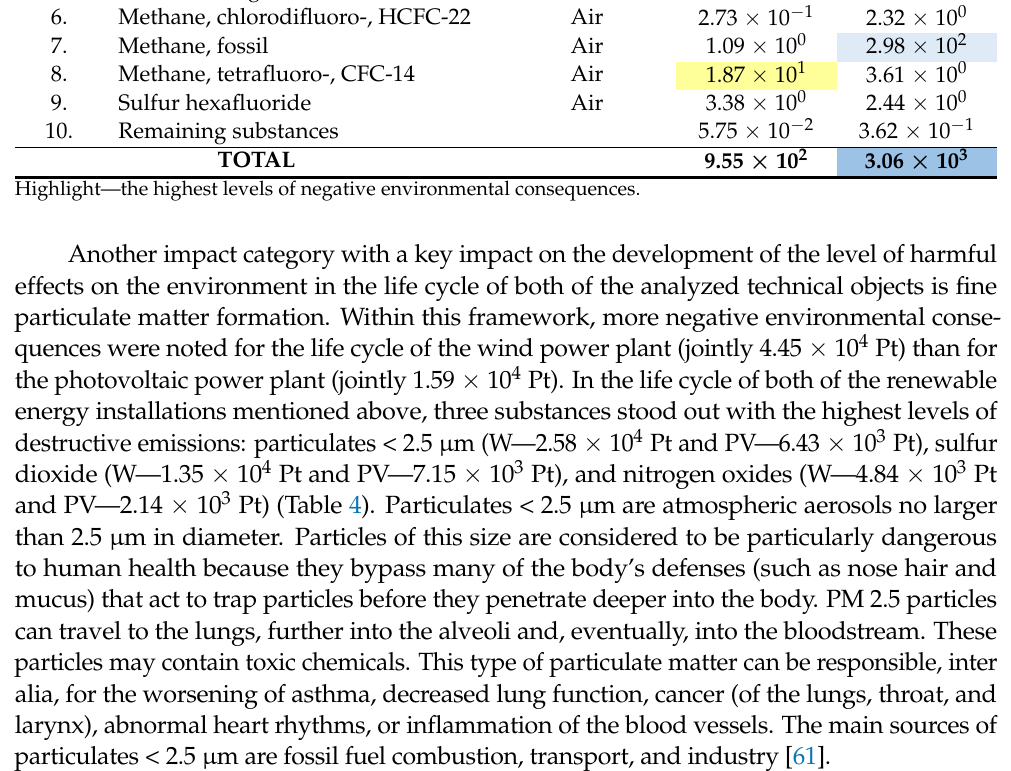
Table 4. Grouping and weighting results of environmental effects for fine particulate matter formation present in the life cycle of wind (W) and photovoltaic (PV) power plants (unit: Pt).